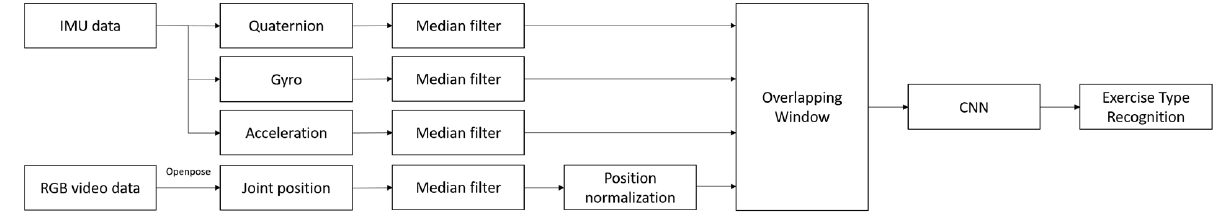
Figure 6. Overall architecture of the convolutional neural network (CNN). The IMU data (quaternion, gyro, and acceleration data) were filtered through a moving median filter (MMF) and the RGB video data were converted to joint position estimation data by OpenPose. Joint position data were filtered through the MMF and normalized by the neck position.